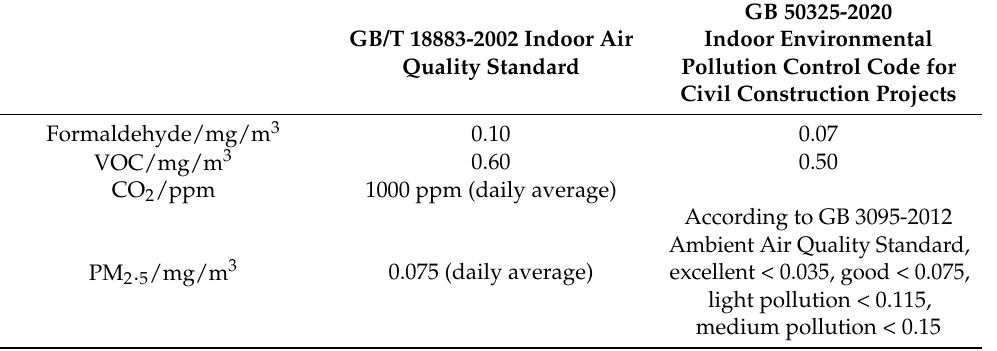
Table 2. Differences between standards.